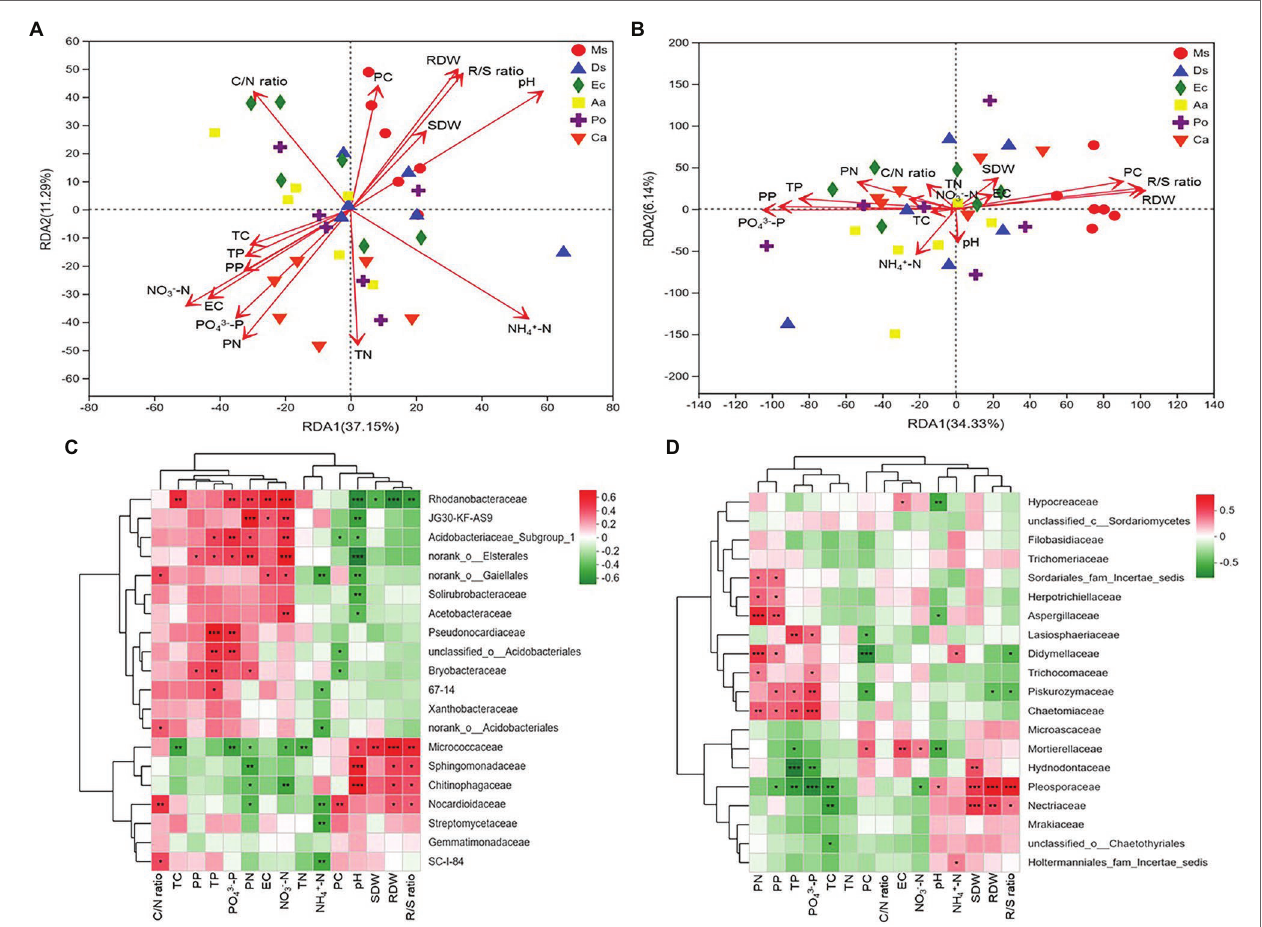
FIGURE 5 | RDA plots showing the effects of plant and soil properties on the bacterial (A) and fungal (B) community structures at the family level from root- associated alfalfa and weed soil. Spearman correlation heat map showing the relationship between bacterial (C) and fungal (D) classifications at the family level and environmental variables (plants and soil). * p < 0.05, ** p < 0.01, and *** p <